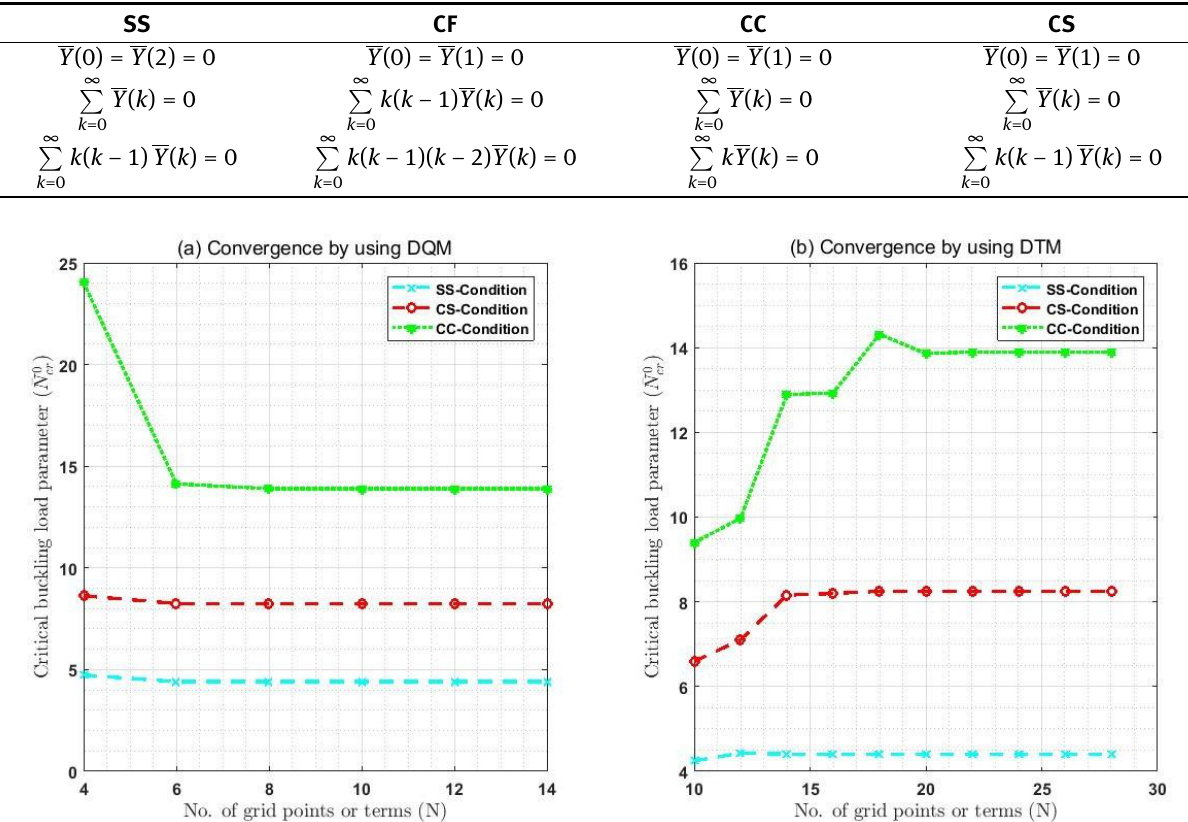
Figure 1: Critical buckling parameter Vs. number of terms (grid points) for both DQM and DTM